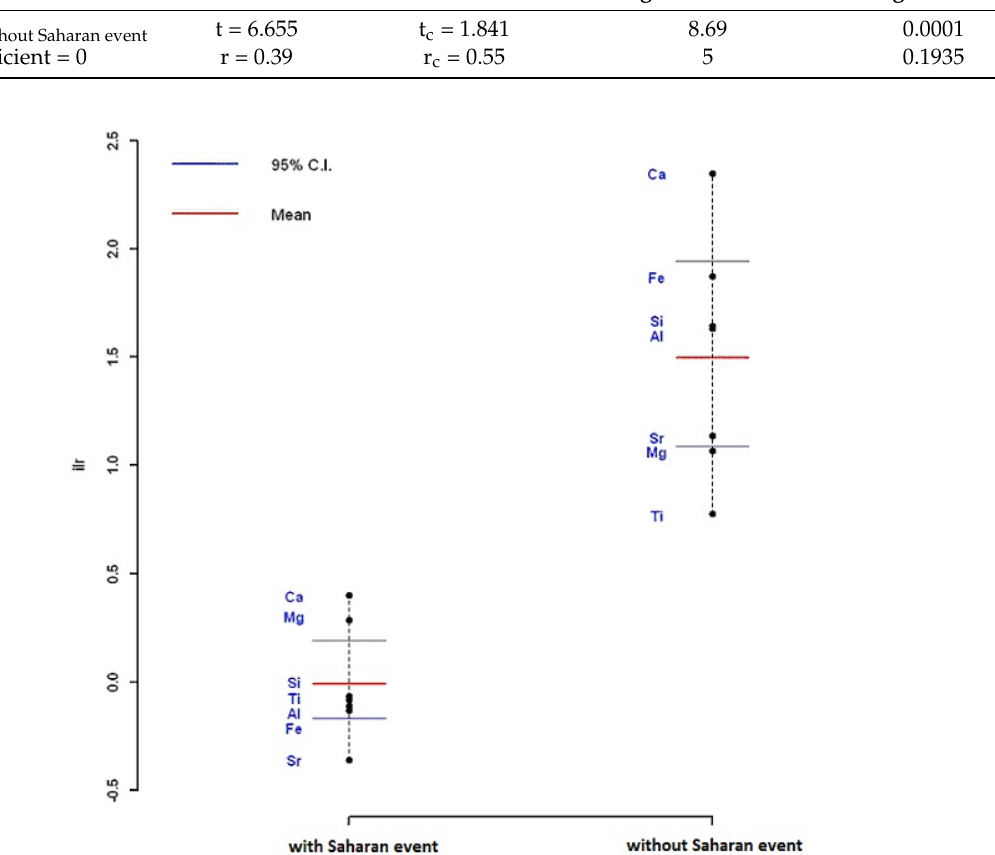
Figure 3. Distribution of data for isometric log-ratios. The mean of ilr relating to the compositional dataset of days with a Saharan event is at about 0.01 with the 95% C.I. ( − 0.17, 0.19). The mean of ilr relating to the compositional dataset of days without a Saharan event is at about 1.5 with the 95% C.I. (1.05, 1.95).